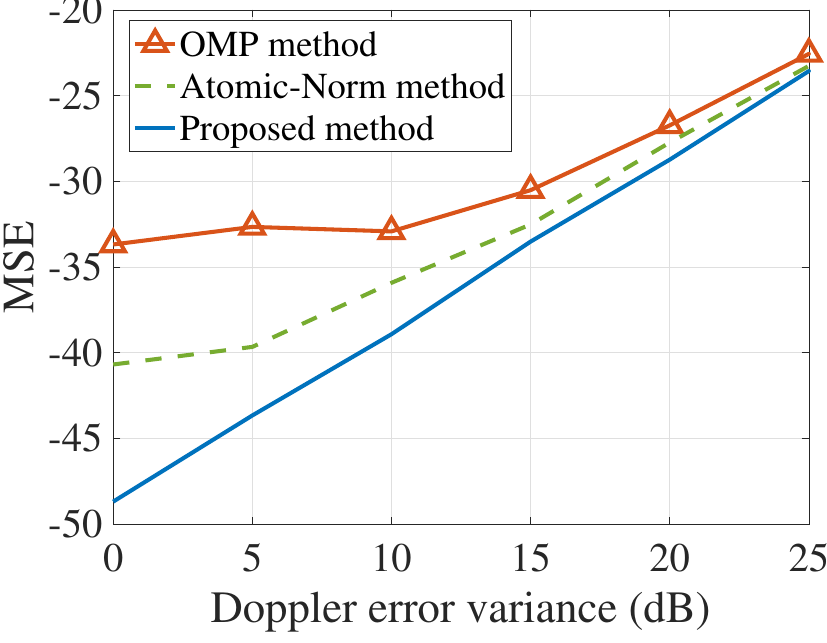
Figure 5. Compared with the existing